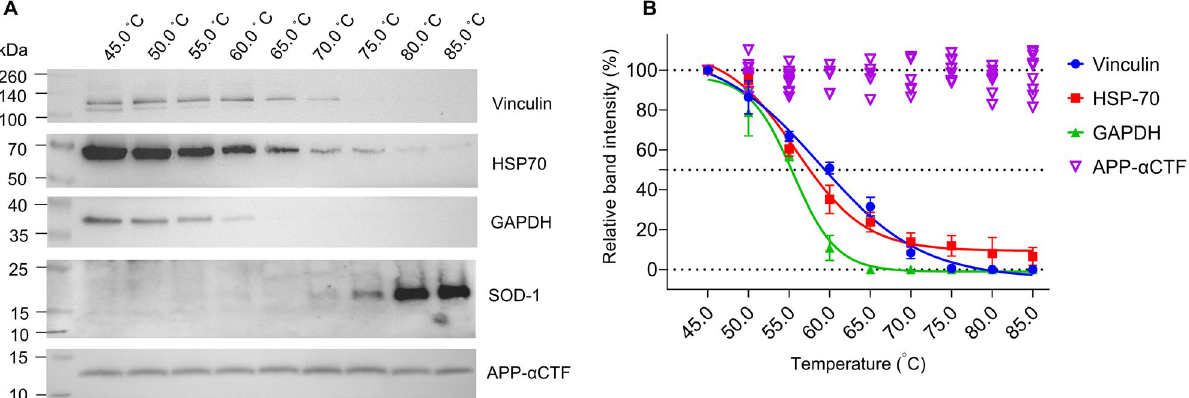
Figure 2. Cellular protein stability, over a 45–85 °C temperature range, of two commonly used protein loading controls (Vinculin (filled blue circle) and GAPDH (filled green triangle)) and temperature stable proteins, heat shock protein 70 (HSP70 (filled red square)) and superoxide dismutase-1 (SOD-1) in comparison to APP-αCTF (open purple inverted triangle). ( A ) A representative cropped western blot of each analysed protein in the soluble fraction from HEK293 cell lysate after temperature exposure with ( B ) the corresponding relative band intensity sigmoidal curves as mean ± SD used to determine the Tagg for each, calculated by setting the highest intensity for each data set as 100% and the curve generated using the Boltzmann sigmoidal equation (n ≥ 3). Also refer to Figs. S1 and S2 (see supplementary information file, raw data images for full-length western blots).